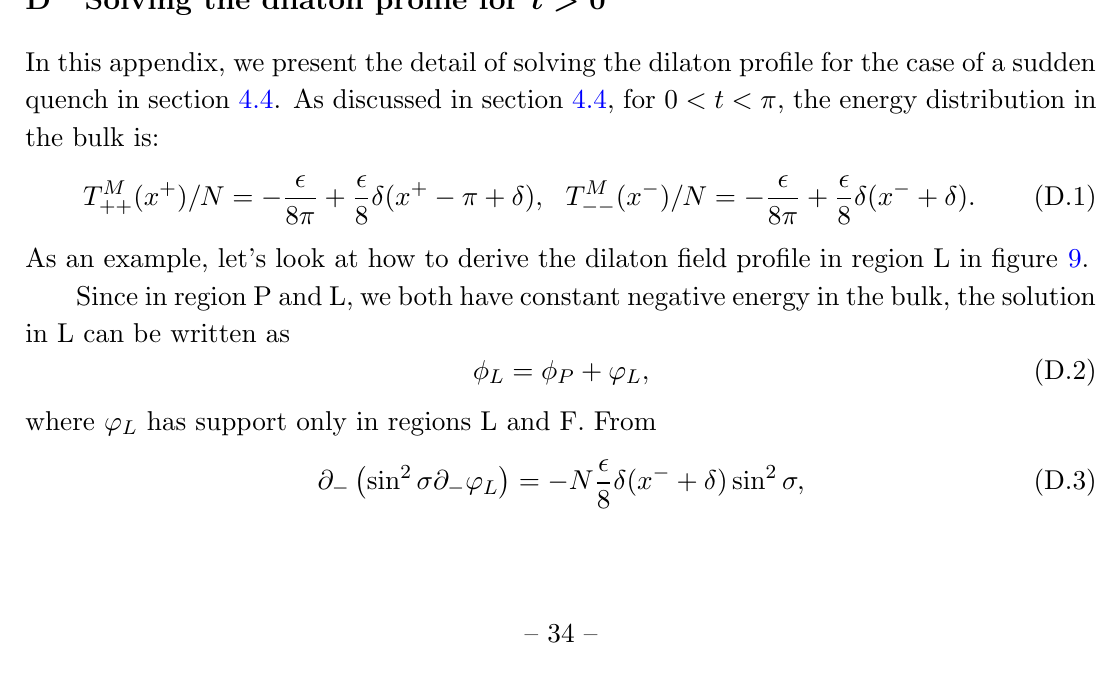
Figure 9 . The two shock waves (orange lines) divide the bulk into four regions, which we denote as L (left), R (right), F (future), P